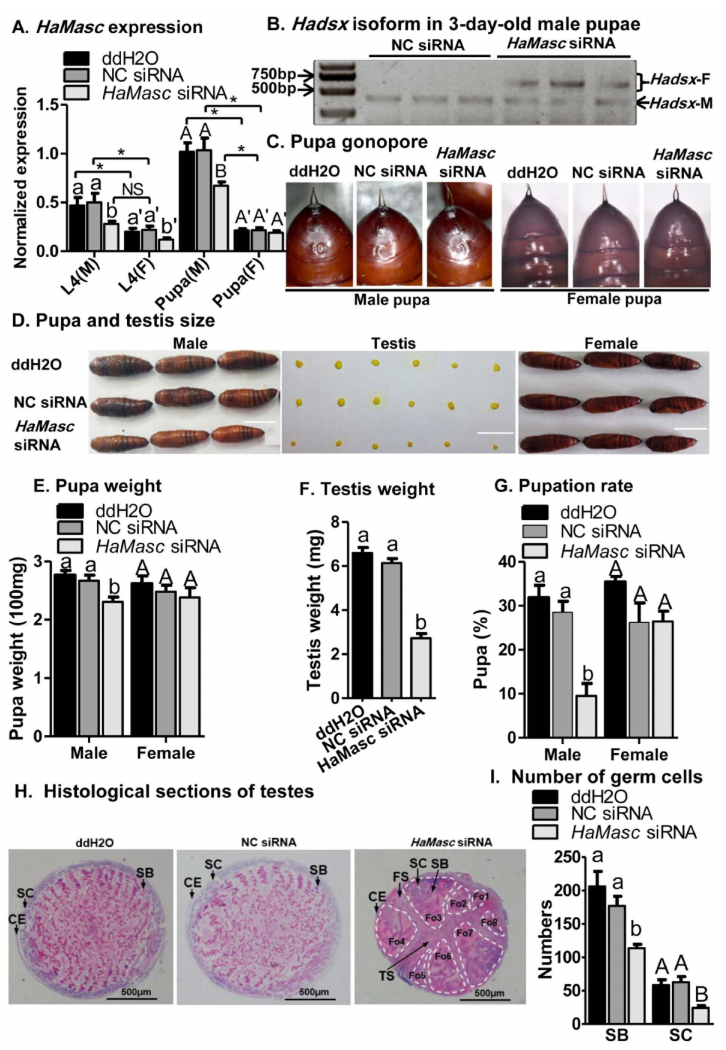
Figure 7. Impacts of HaMasc siRNA mixture on H. armigera larvae. HaMasc expression ( A ; M = male, F = female), splicing of Hadsx in 3-day-old male pupae ( B ), pupa gonopore ( C ), pupa and testis size ( D ), pupa weight ( E ), testis weight ( F ), pupation rate 2 weeks after delivery of siRNAs ( G ), testis development and structure and, ( H ) germ cell number ( I ). Bars in ( A , E – G , I ) are means ± SE of normalized expression of HaMasc , pupa weight, testis weight, pupation rate, and germ cell number, respectively. Bars with different letters (a, b, A, B, A’ in Figure 7A,E–G,I) are significantly different at p < 0.05 (one-way ANOVA followed by Tukey’s HSD test). Photographs of representatives of 3-day-old pupa ( D ), their gonopore ( C ), and male testes ( D ) from each treatment group (ddH 2 O, NC siRNA, HaMasc siRNA mixture) were taken with a camera ( D : bar = 1 cm). Hematoxylin and eosin (HE) staining of histological sections of the testis from 3-day-old male pupa ( H : bar = 500 µ m) shows that the internal fusion process of two bilaterally symmetrical testes into one single testis was completed in ddH 2 O and NC siRNA pupa but not in HaMasc siRNAs pupa, as manifested by the presence of septa between the two testes (TS in H ) and between the four follicles within each testis (FS in H ) in HaMasc siRNAs pupa but not in ddH 2 O and NC siRNA pupa. The notable eight follicles (Fo 1–8) in HaMasc siRNAs pupa are surrounded by white dotted lines. FS = follicle septa, TS = testis septa, CE = coating epithelium, SC = spermatocytes, SB = sperm bundle. Bar pairs with one asterisks ( p < 0.05, independent t